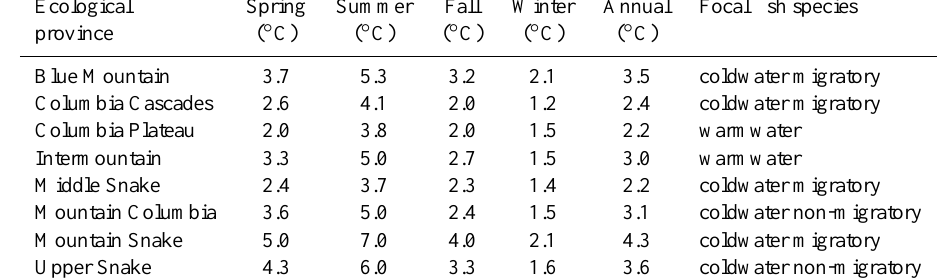
Table 3. Stream temperature changes and focal fish species groups for the Columbia River basin ecological provinces during the 2080s. Ecological